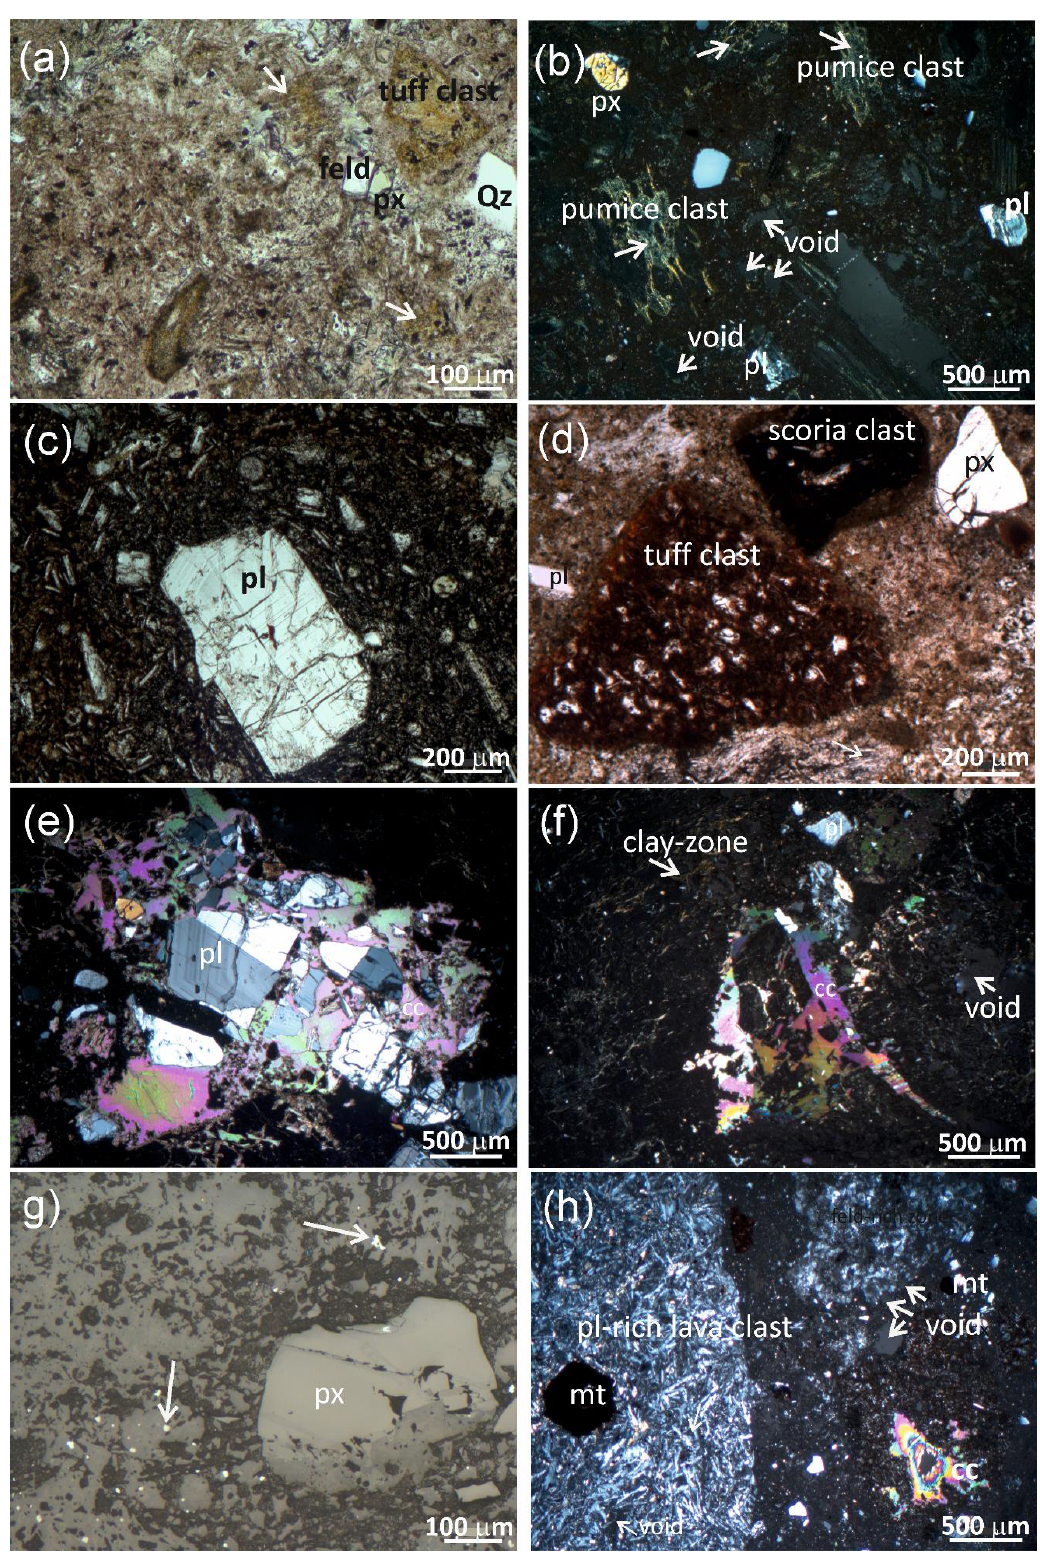
Figure 3. The reservoir rocks cored at San Vito 1 well under the optical microscope: ( a – c ) the yellow tuff cored at 804 m of depth from the argillic facies and ( d – h ) the chaotic tuffs (representing the modeled Campanian Ignimbrite formation) cored at depths of 1412 and 1417 m from the phyllic facies (refer to Figure 2a for the downhole location and aspect of cores). The light is plane- polarized in ( a,d ), cross-polarized in ( b,c,e,f,h ) and reflected in ( g ). ( a ) The tuff cored at 804 m consists of a yellowish, nearly